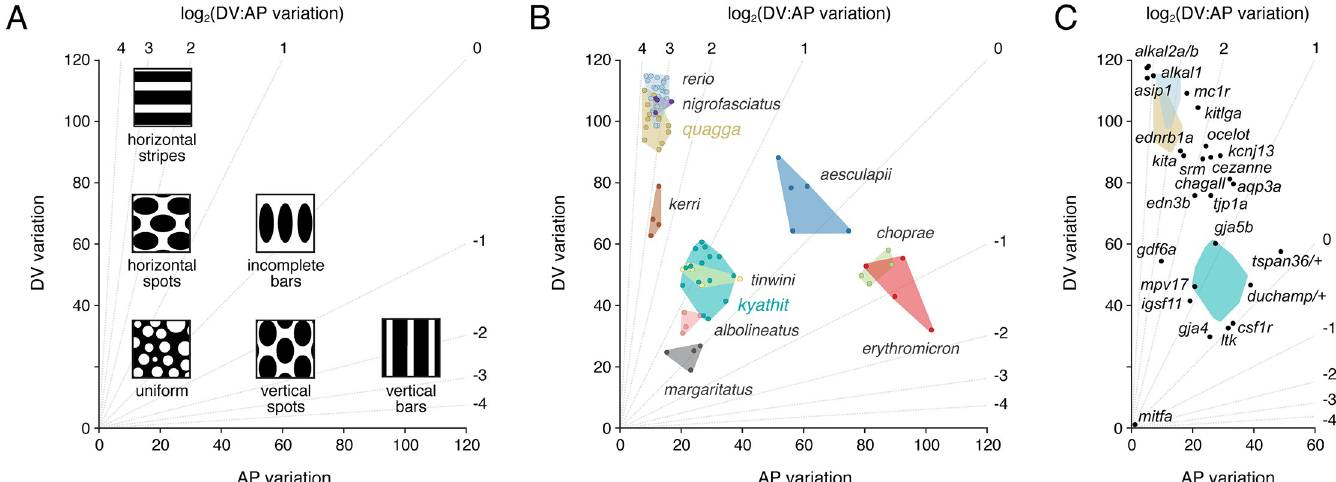
Fig 3. A morphospace describing pattern variation. (A) Schematic illustrating where idealized patterns fall in a morphospace defined by DV (dorsoventral) and AP (anteroposterior) pattern variation of melanized elements. Diagonals indicate different log 2 values for the ratio of DV variation: AP variation. (B) Mapping of pattern phenotypes in this morphospace revealed overlap of striped D . rerio , D . quagga , and D . nigrofasciatus , and their difference in morphospace from spotted D . kyathit or D . tinwini . Additional species occupied distinct regions of morphospace as well. Images of other Danio species have been published previously [4,16,19].Points denote individuals and shapes denote observed phenotypic range. (C) Several single locus mutants of D . rerio lie between D . quagga and D . kyathit , or in the vicinity of D . kyathit . These phenotypes arise from null or hypomorphic alleles [22,27, 37,38,42,51,62–64,76,85,86,98–101],though aqp3a results from an activating mutation [53], and some mutants have yet to be characterized molecularly ( cezanne , chagall , duchamp , ocelot ) [8,84].Points for each mutant denote individuals, or averages when images of multiple individuals were